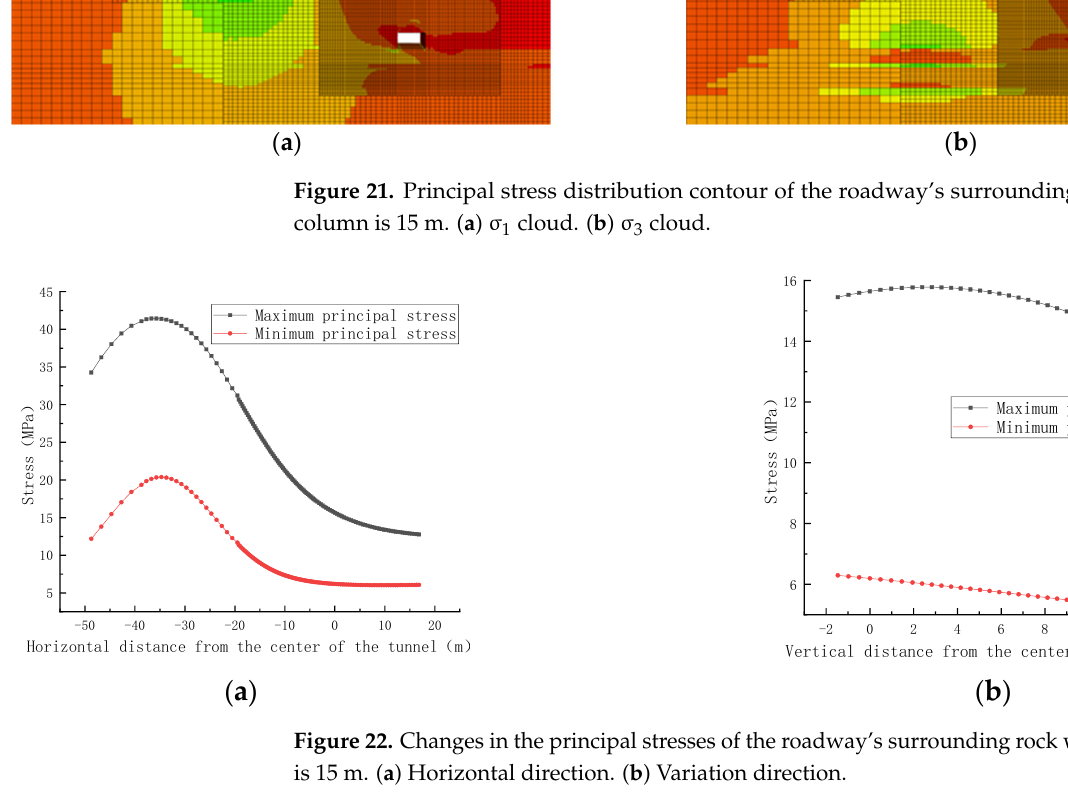
Figure 20. Plastic zone distribution cloud map when the coal column is 8 m. (3) The coal column is 15 m Figure 21. Principal stress distribution contour of the roadway ’s surrounding rock when the coal column is 15 m. ( a ) σ 1 cloud. ( b ) σ 3 cloud. the roadway is about 5 – 26 MPa, and σ 3 is about 0.6 – 5 MPa.